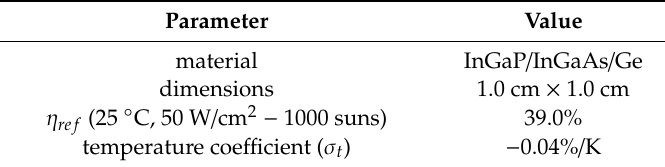
Figure 1. Linear focus experimental Concentrator Photovoltaic and Thermal (CPV/T) plant. Table 1. Characteristics of the Triple-Junction (TJ) solar cells.